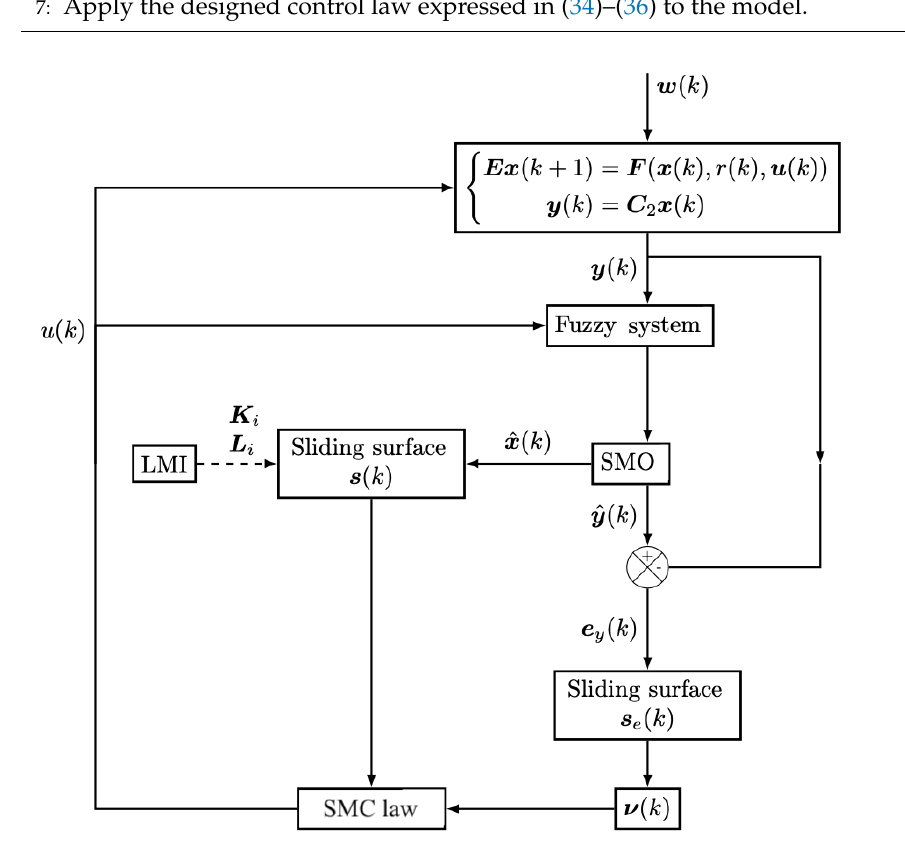
Figure 1. Flowchart of the control